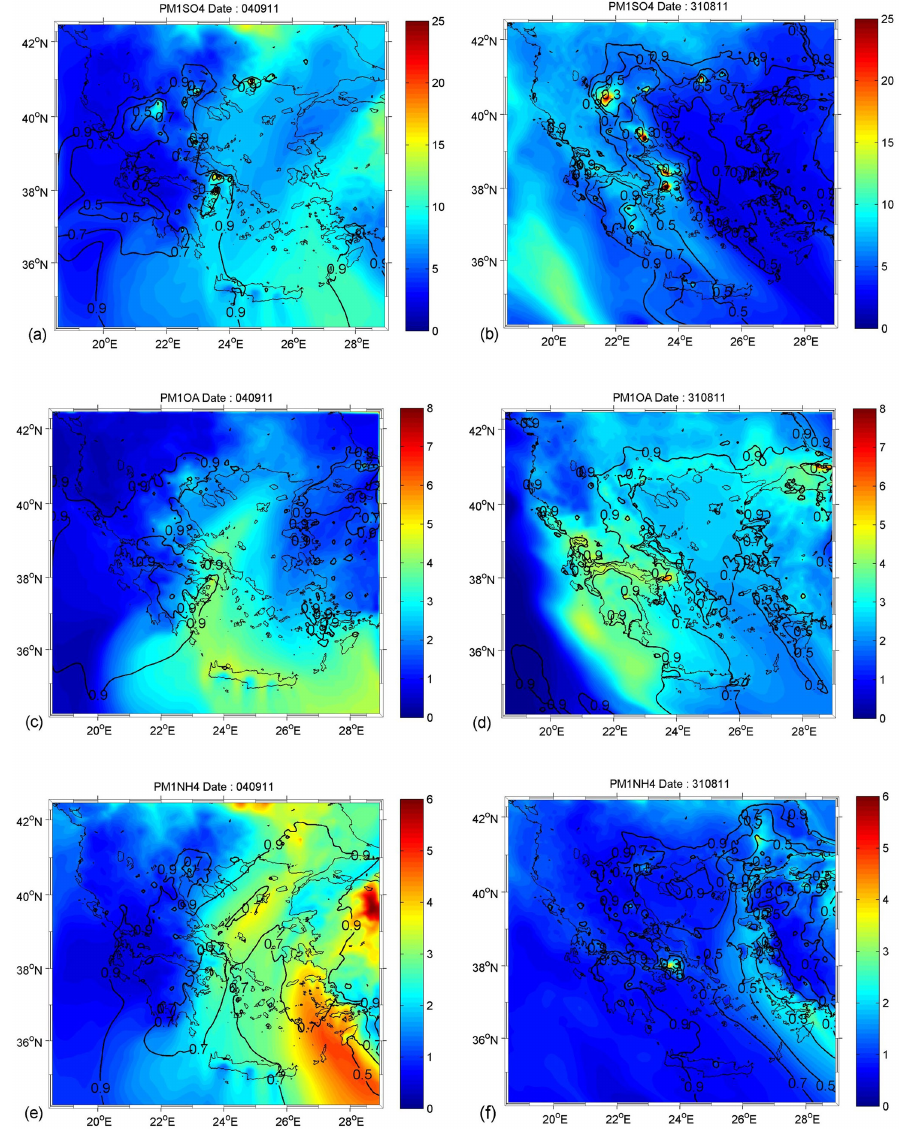
Figure 4. Daily average PM 1 lowest level concentration fields (µgm − 3 ) of sulfate, organics and ammonium species, during: (a) , (c) , (e) NE winds (04 September 2011) and (b) , (d) , (f) NW winds (31 August 2011), blowing over the Aegean Sea. Iso-lines show the contribution of trans-boundary sources to the total aerosol mass [(standard run – scenario 1) / standard